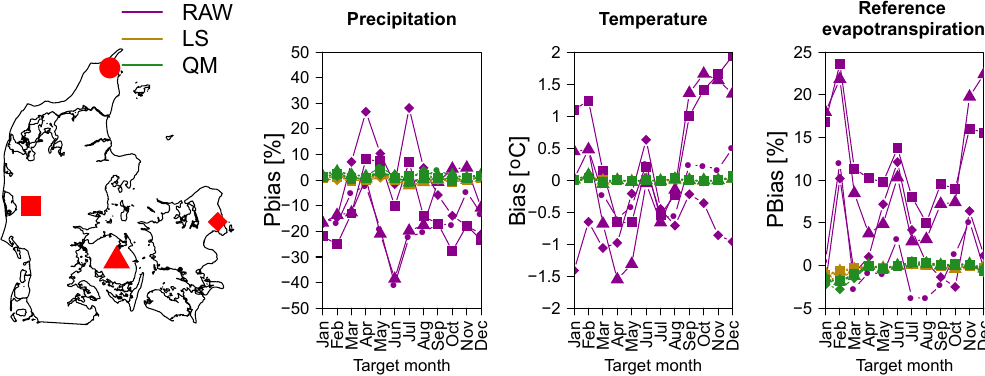
Figure 8. Biases of raw and post-processed precipitation, temperature and E T0 at four locations in Denmark. Biases are for the different target months and for a lead time of 1 month. Different locations are represented with different symbol shapes according to the map on the left, whereas the raw and the different post-processing techniques are represented with different